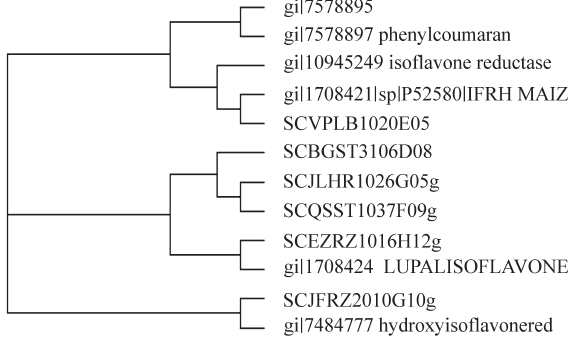
Figure 3 - Cladogram of cDNAs coding for putative isoflavone reduc- thases and corresponding IFR genes from other plants. * Multiple alignment analysis was performed with Clustal X program (www.igbmc.u-strasbg.fr). The length of the horizontal lines indicates an inverse degree of related- ness.